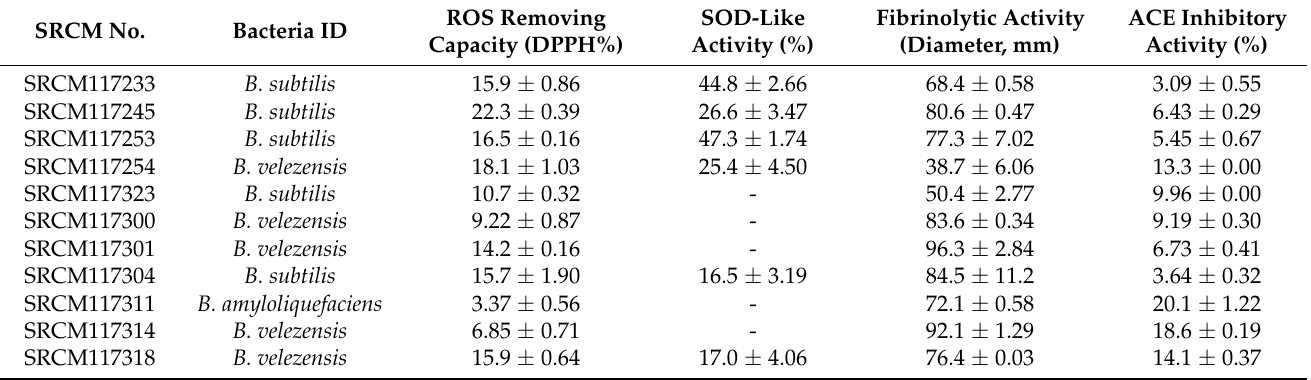
Table 3. Functionalities of isolated Bacillus spp. from traditionally made Kochujang. SRCM No.